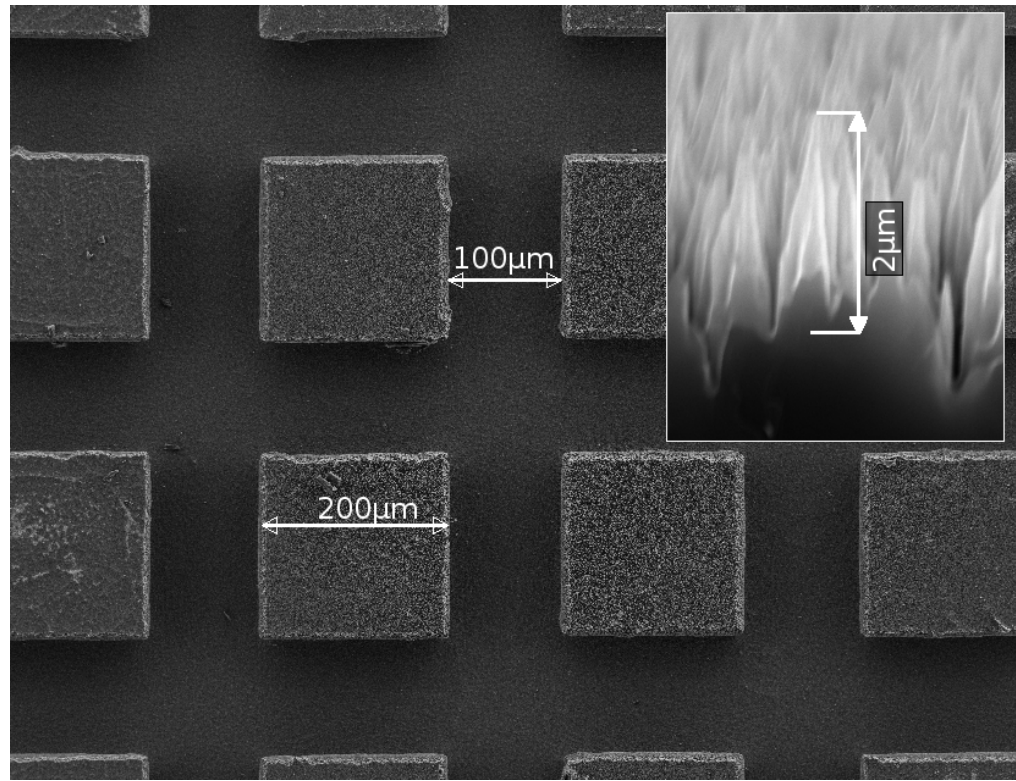
Figure 3. Scanning electron microscope (SEM) image of the square pillar flow field. Inset: black silicon on top of a